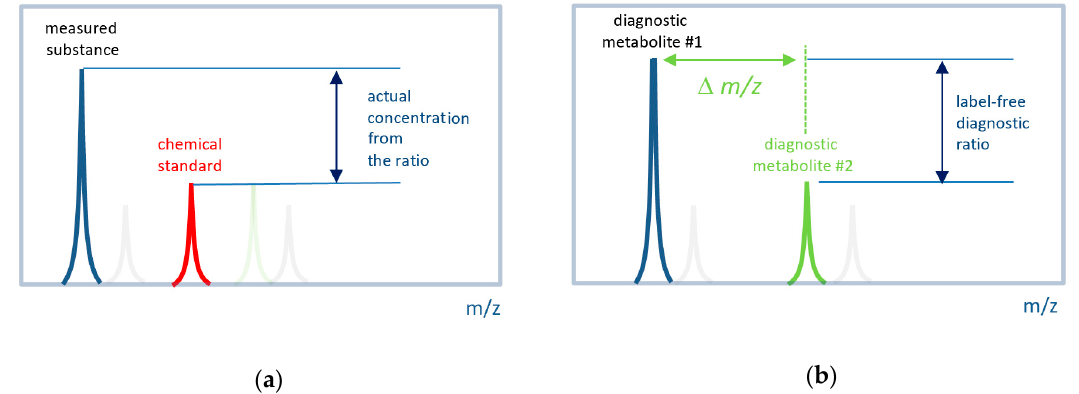
Figure 1. Concept of label-free in situ direct mass spectrometry-based diagnostics. ( a ) The conventional approach to measure the actual concentration of a substance by mass spectrometry. Labeled (e.g., by isotope) chemical standard is introduced into a sample with a known concentration. The ratio of a measured substance to its labeled standard is used to define the actual concentration. ( b ) The label-free approach uses signals (mass peak intensities) from two metabolites associated with the disease. It is expected that their ratio also has diagnostic power. A set of such ratios for many metabolites can be used to compile a diagnostic signature. The difference between the m/z ( ∆ m/z) values must be small so that both peaks can be measured with the same instrumental parameters.